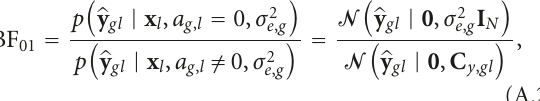
estimate TF’s protein activities and studying phenotypes based on TF’s protein activities could yield more informative and accurate